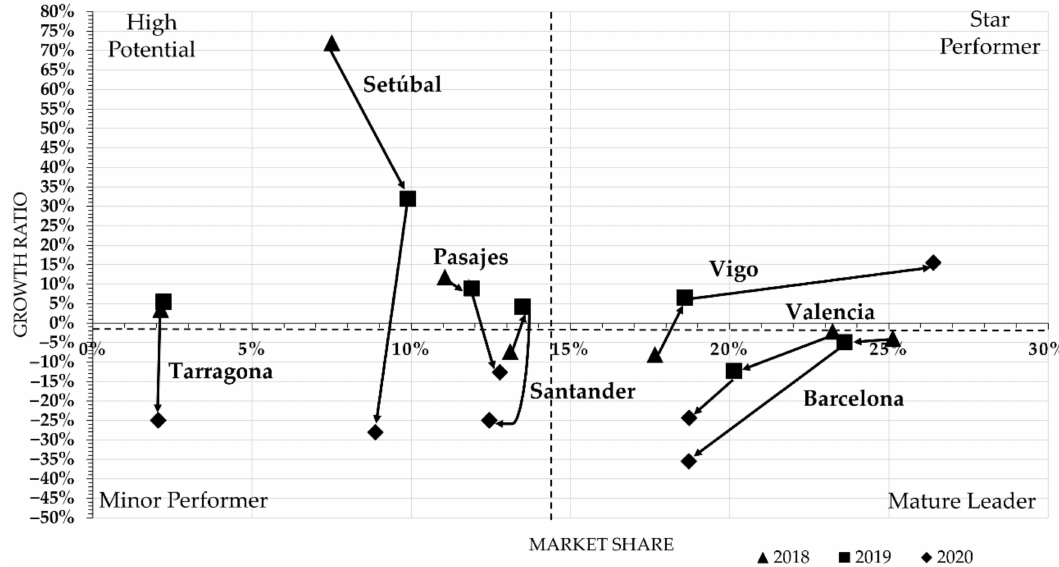
Figure 7. Matrix with dynamic portfolio analysis of port competitive positions for vehicle embarking traffic during the period from 2018 to